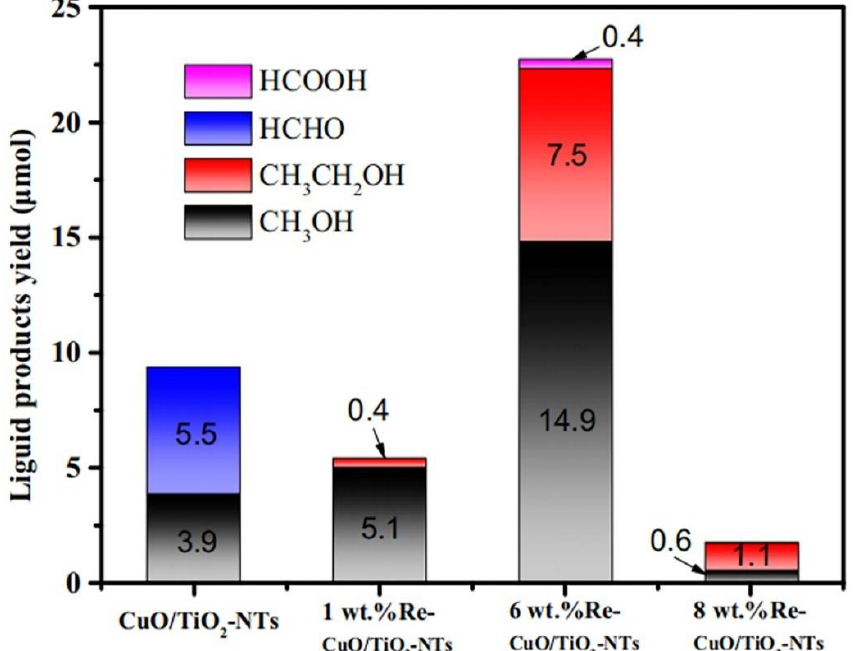
Figure 9. Yields of products over different de-doped CuO/TiO 2 -NTs. Reproduced with permission from reference [80].